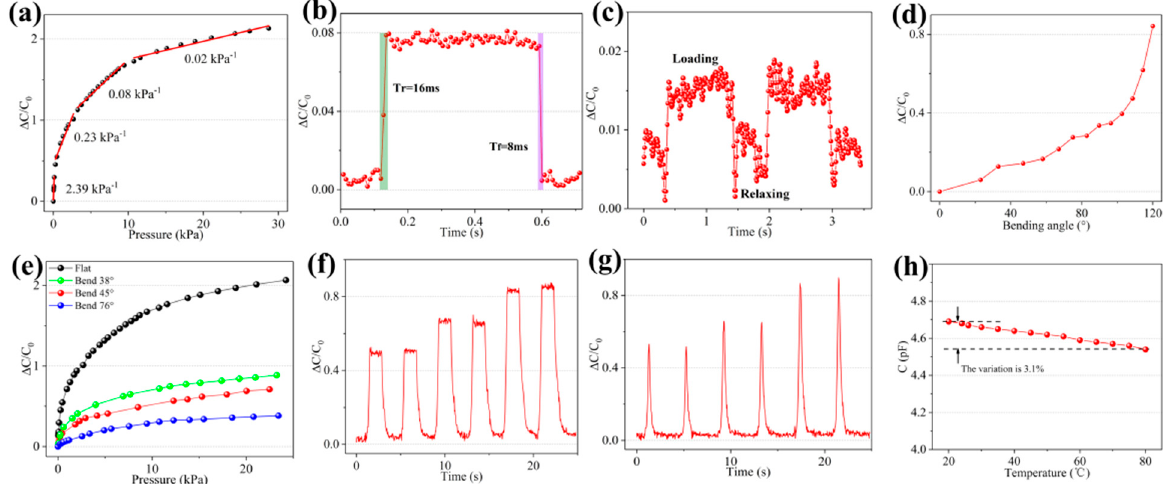
Figure 8. Performance test curve of the sensor. ( a ) Sensitivity. ( b ) Response time and recovery time. ( c ) Limit of pressure sensing. ( d ) Output response of the sensor in the bending state. ( e ) The sensitivity of the sensor in the bending state. ( f ) Detection capability under square wave loading. ( g ) Detection capability under sharp pulse loading. ( h ) Effect of temperature on the sensor performance.